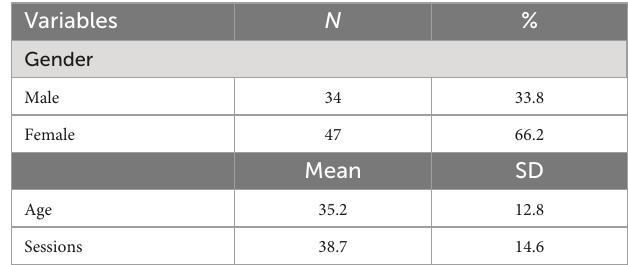
TABLE 1 Demographic and clinical data of the sample ( n =